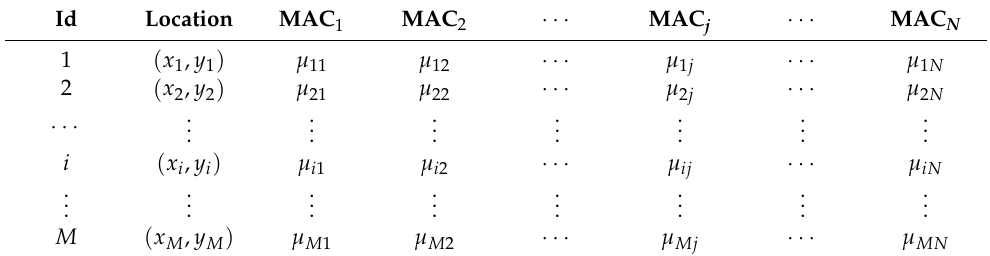
Table 1. The structure of fingerprint database.